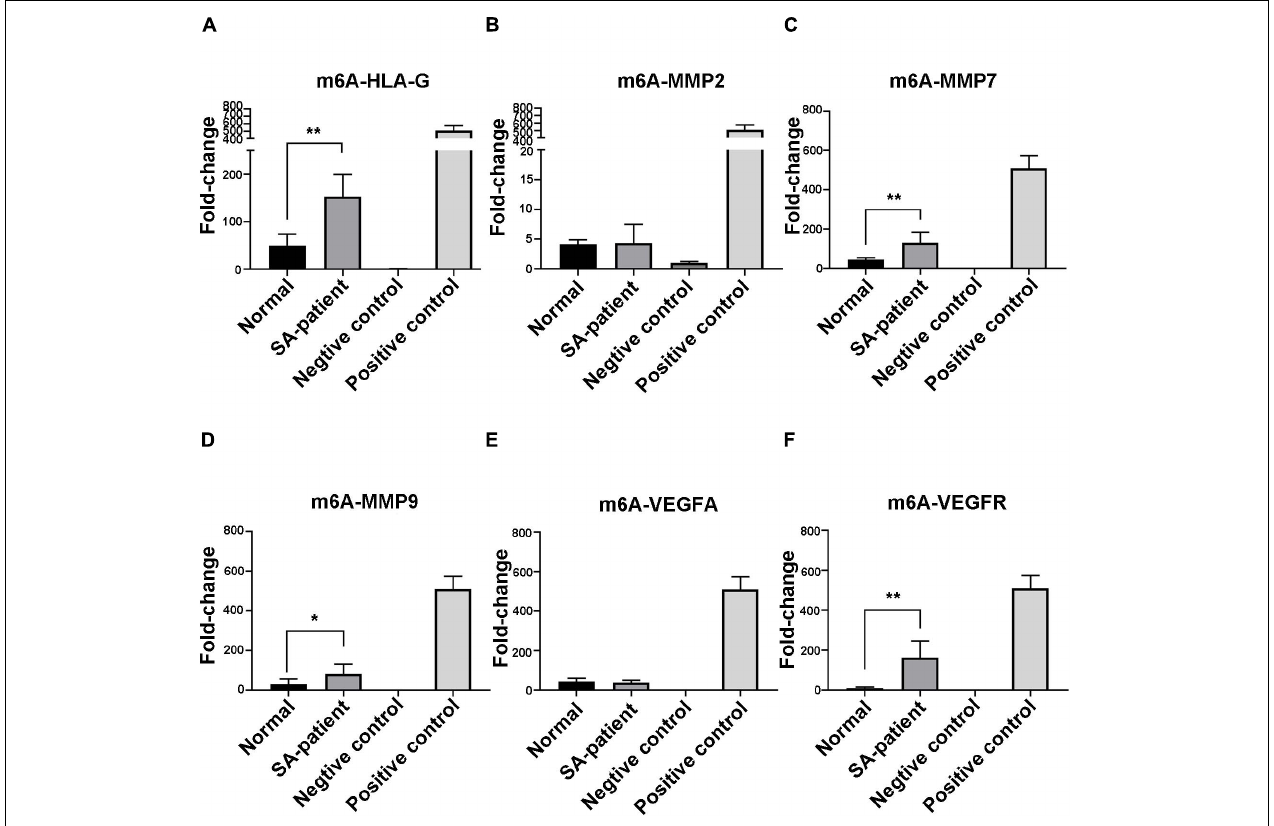
FIGURE 7 | Fold-change in m 6 A-bound (A) HLA-G , (B) MMP2 , (C) MMP7 , (D) MMP9 , (E) VEGFA , and (F) VEGFR mRNA in the chorionic villi of the indicated groups (Normal n = 9; Patient n = 9, * P < 0.05, ** P <